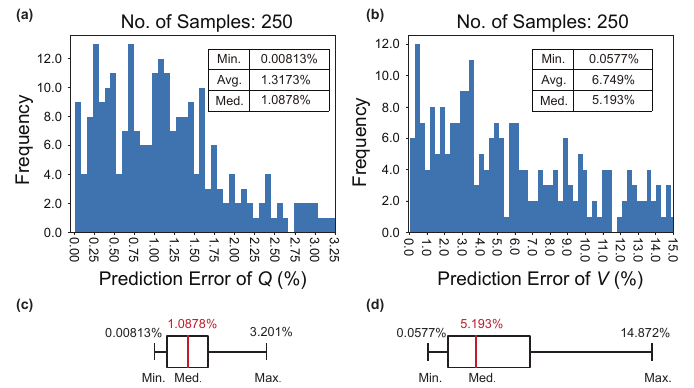
Figure 7. Validation results of the trained LRS-RCNN for nanobeam using the validation dataset. Plotted is the histogram of (cid:101) pred for Q in ( a ) and V in ( b ). The boxplot in ( c ) is extracted from data in ( a ), and ( d ) from ( b ). Inset data: minimum, average, and median (cid:101) pred values in the histograms.